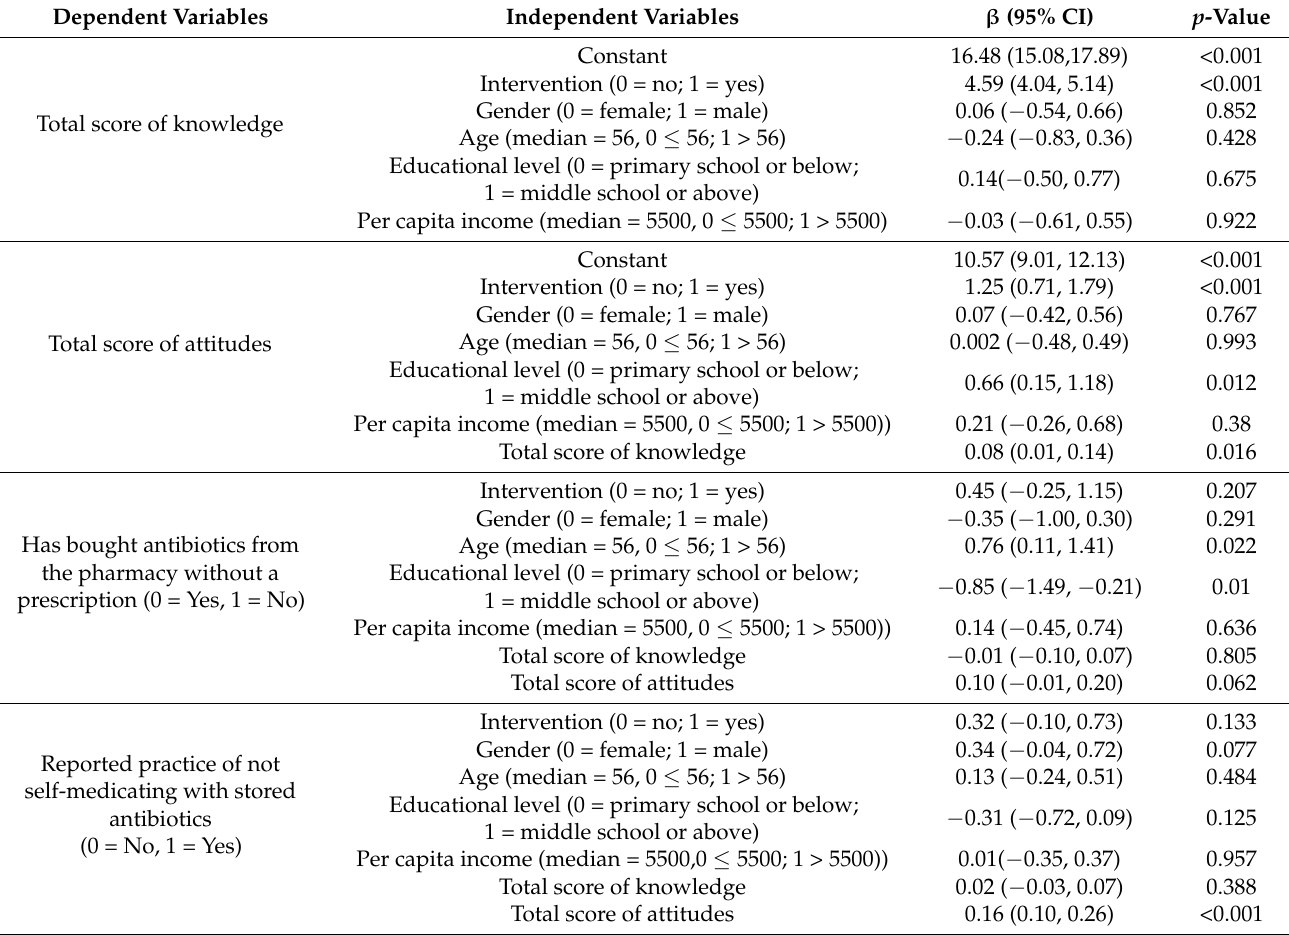
Table 4. Multiple linear regression analysis for improvement on antibiotic use for